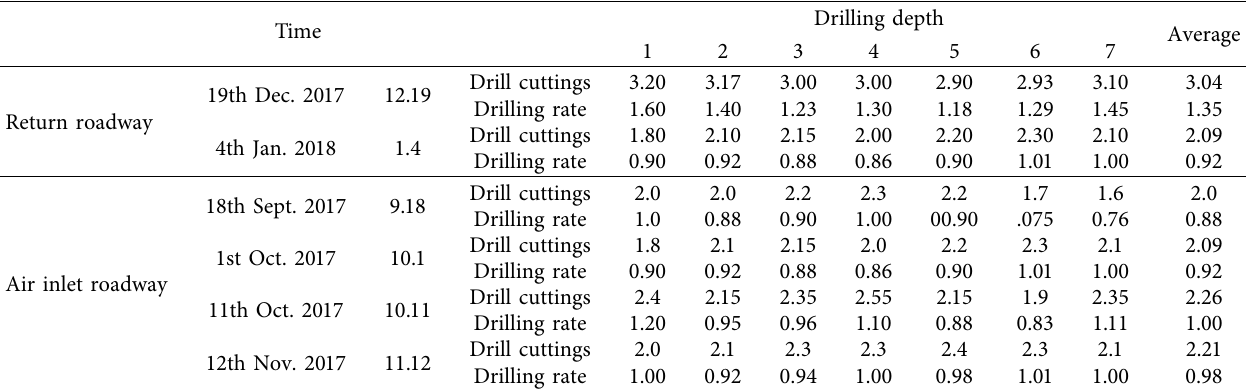
Figure 6: Variation of electromagnetic radiation intensity. Table 3: Drill cuttings experimental data statistics